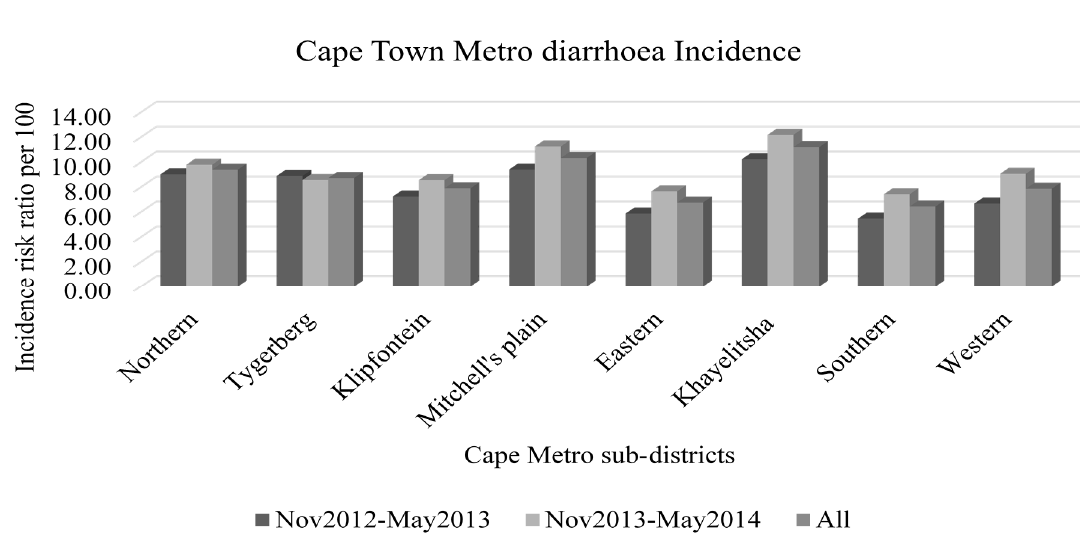
Table 3. Effect of 5 °C increase in minimum and maximum temperature.